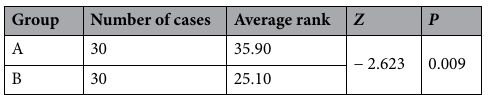
Table 1. Comparison of subjective image quality grading between the